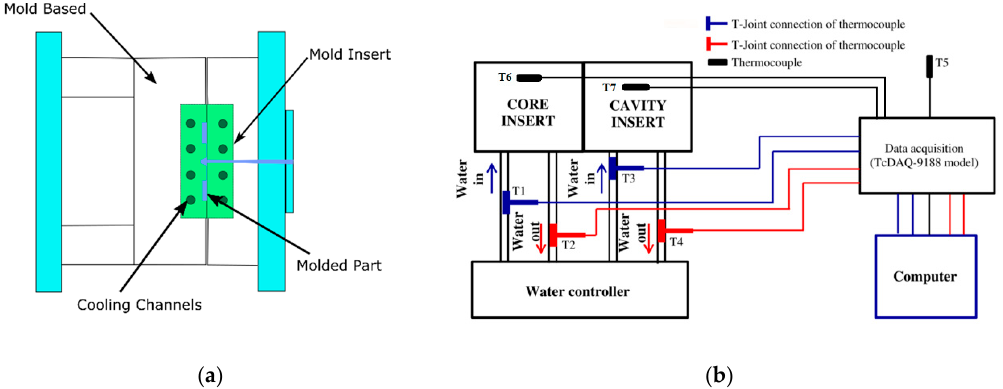
Figure 6. Hybrid mold design was instrumented with seven sensors: ( a ) hybrid mold design; ( b ) schematic diagram connection of the thermocouples.